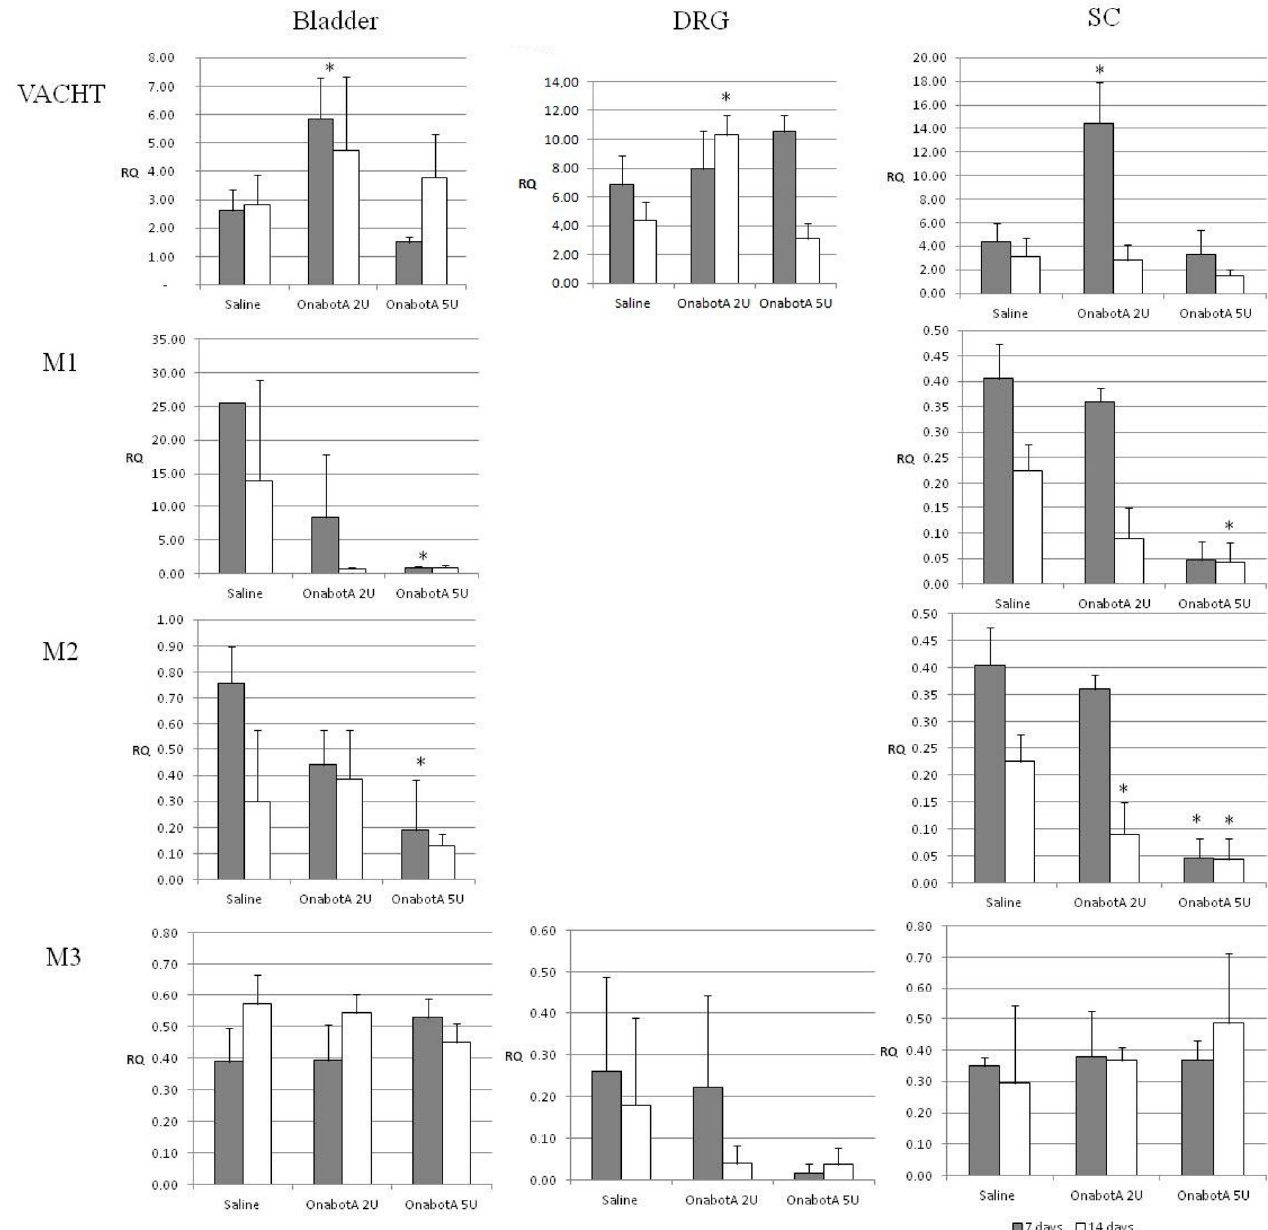
Figure 2. Relative expression of cholinergic markers M1, M2 and M3 in the bladder, DRG (dorsal root ganglia) and SC (spinal cord) of saline-treated (7 days post-treatment, n = 5; and 14 days post- treatment, n = 5) and OnabotulinumtoxinA-treated rats (7 days post-treatment, n = 5; and 14 days post-treatment, n = 5). Expression was normalized to that of GAPDH. RQ: relative quantification. Error bar: standard deviation. *: statistically significant difference ( p < 0.05) with respect to saline. Sympathetic markers: NPY expression increased in the DRGs both at 7 and 14 days in animals treated with 5U OnabotulinumtoxinA, as well as in animals injected with 2U OnabotulinumtoxinA at 7 days post injection. At 14 days post injection with 2U and 5U OnabotulinumtoxinA, a significant increase was noted in the SC. Bladder NPY expression showed a similar incremental trend, but only at 7 days with the 5U dose (Figure 3).